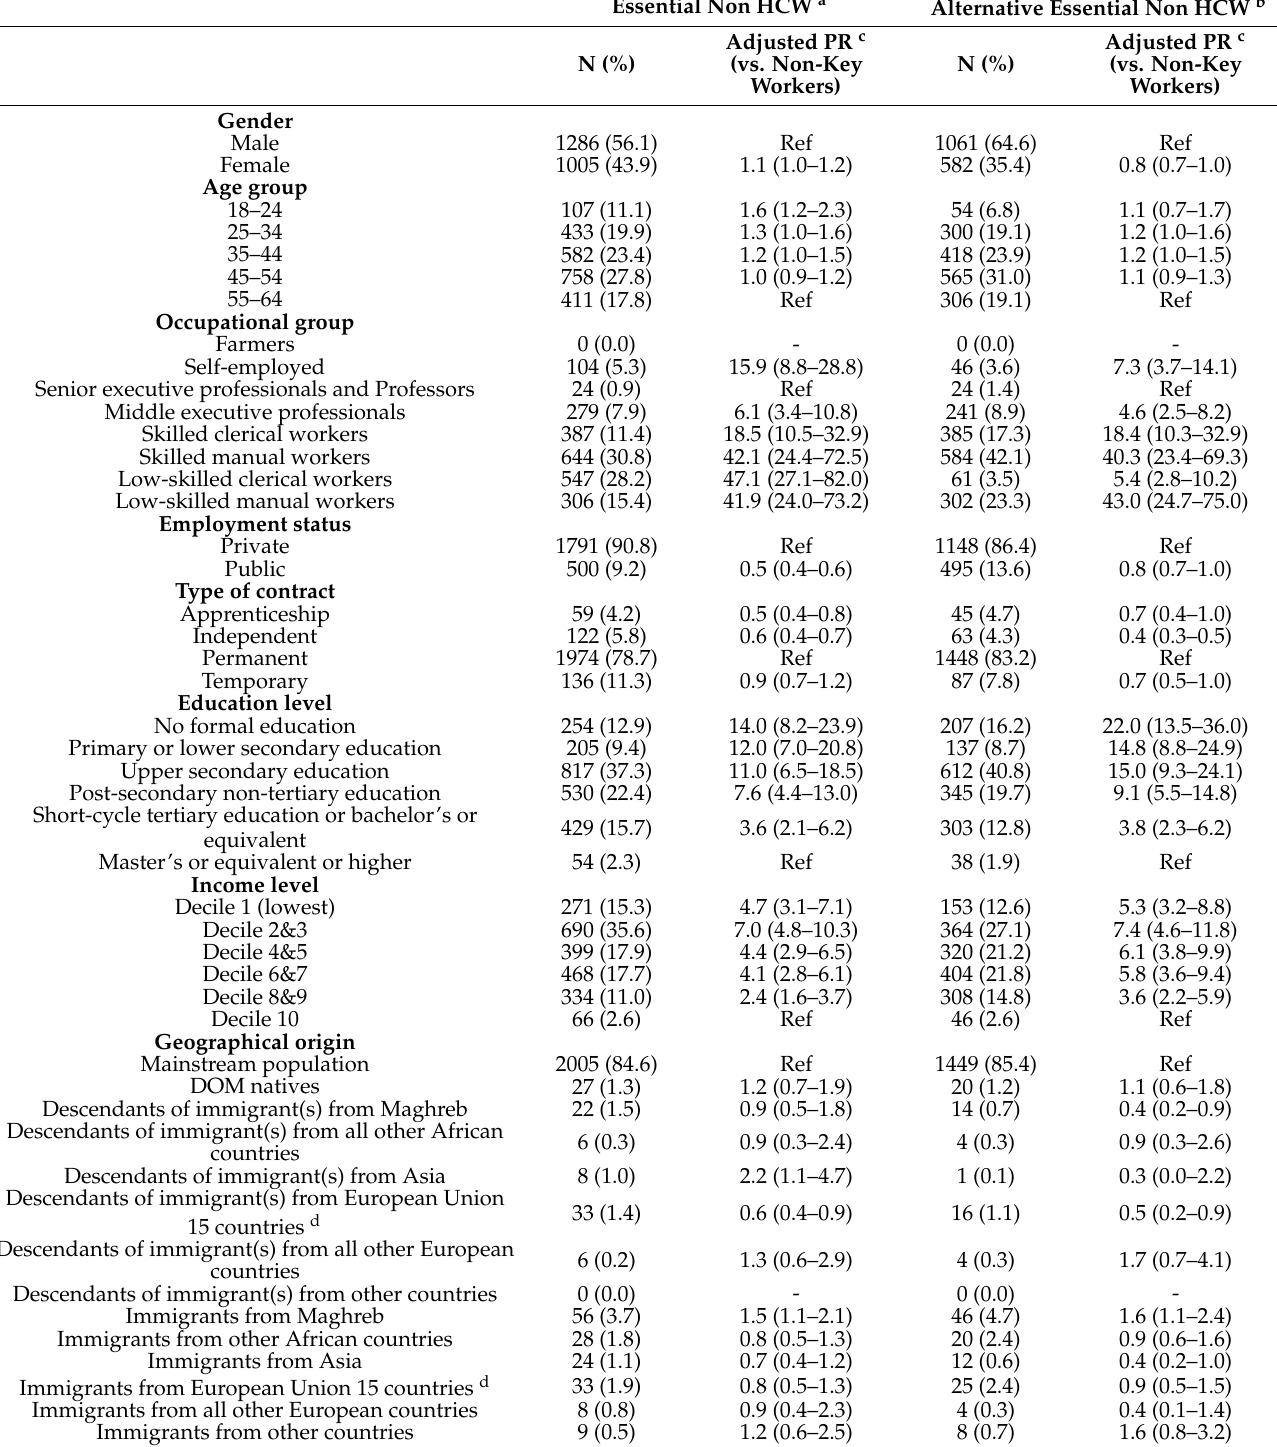
Table A2. Sensitivity analysis: sociodemographic profile and the association between sociodemo- graphic characteristics and being a key worker based on different classifications of the essential non-HCW sub-group of key